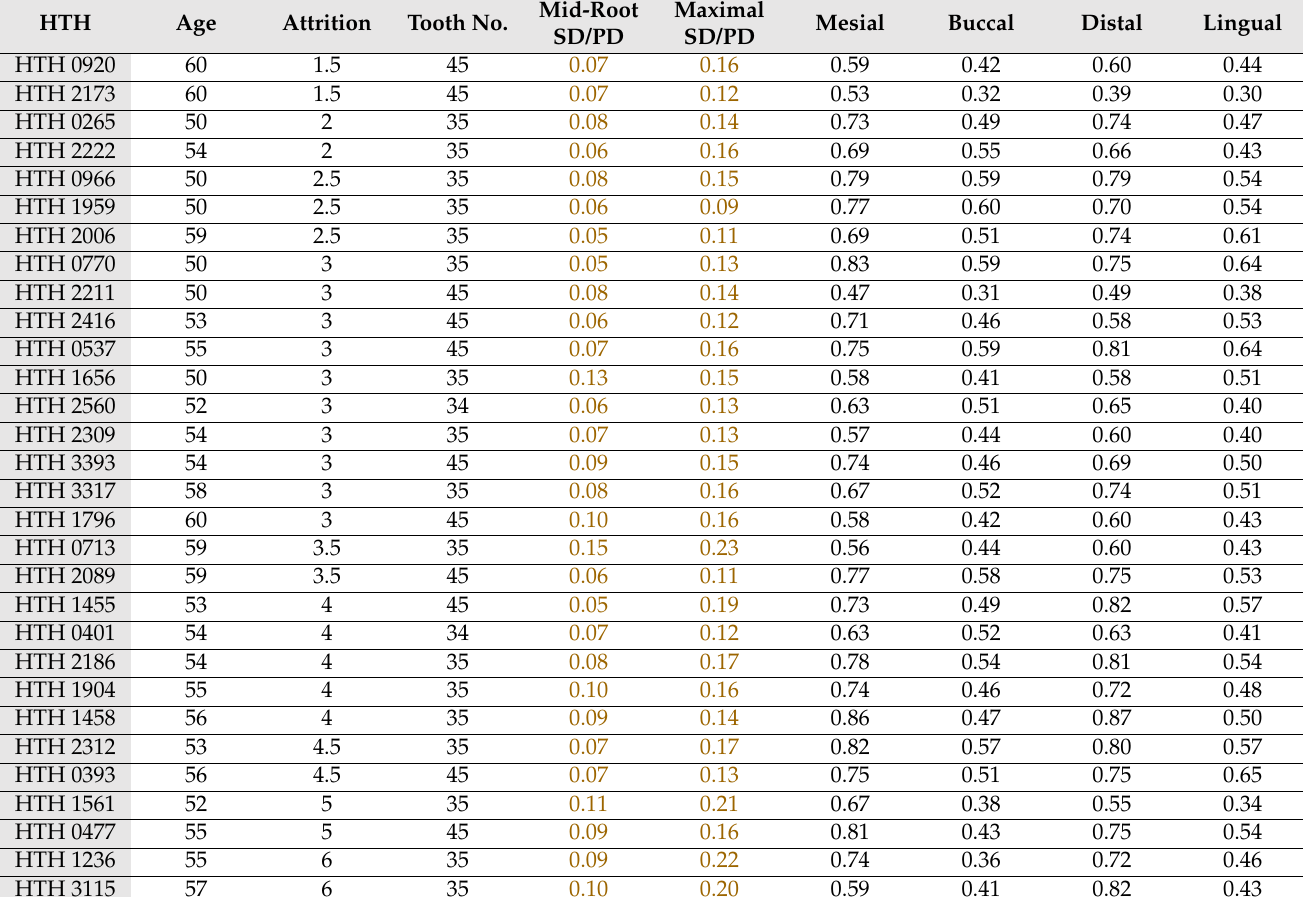
Table 1. Age and attrition distribution of the studied sample. Molnar’s rank for